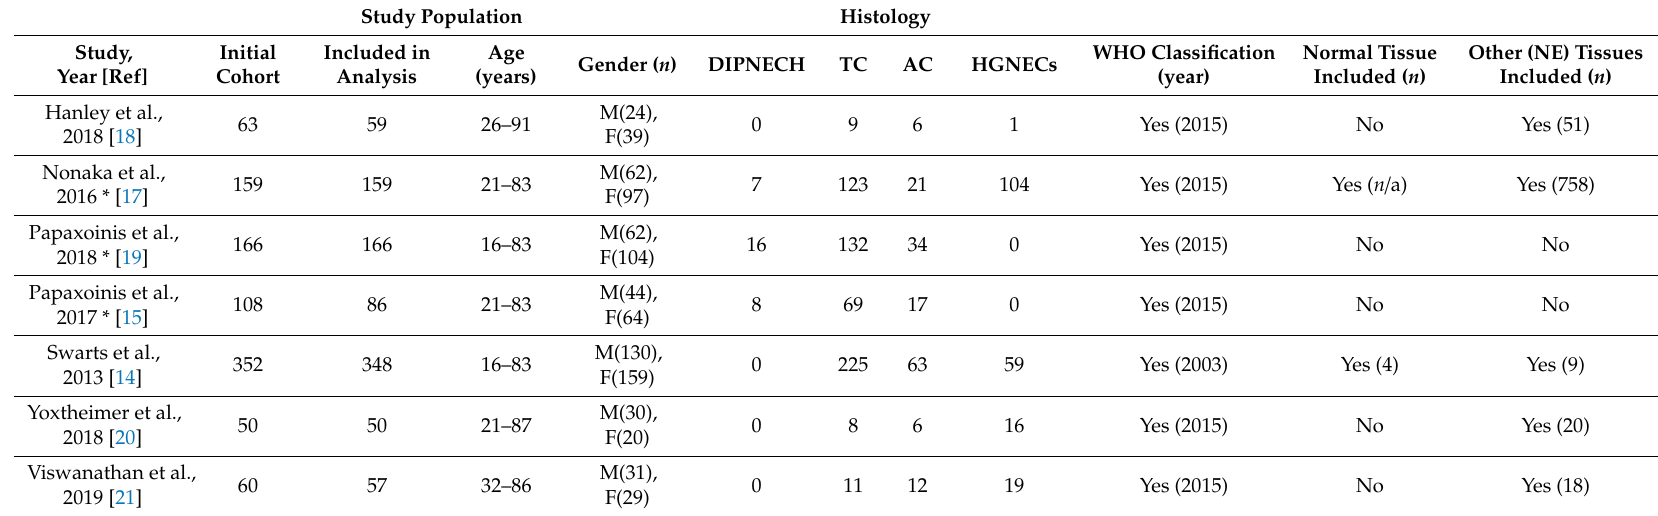
Table 1. Overview of the characteristics of studies that analysed OTP expression in pulmonary carcinoids using immunohistochemistry. Study Population